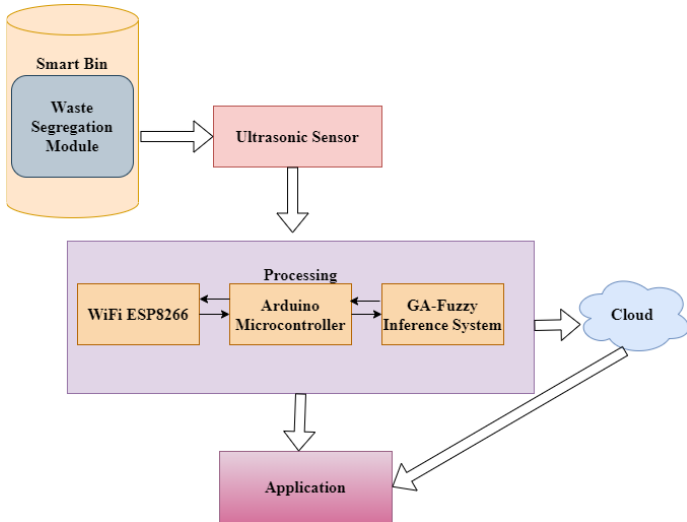
Figure 3. High-level design of the proposed system.